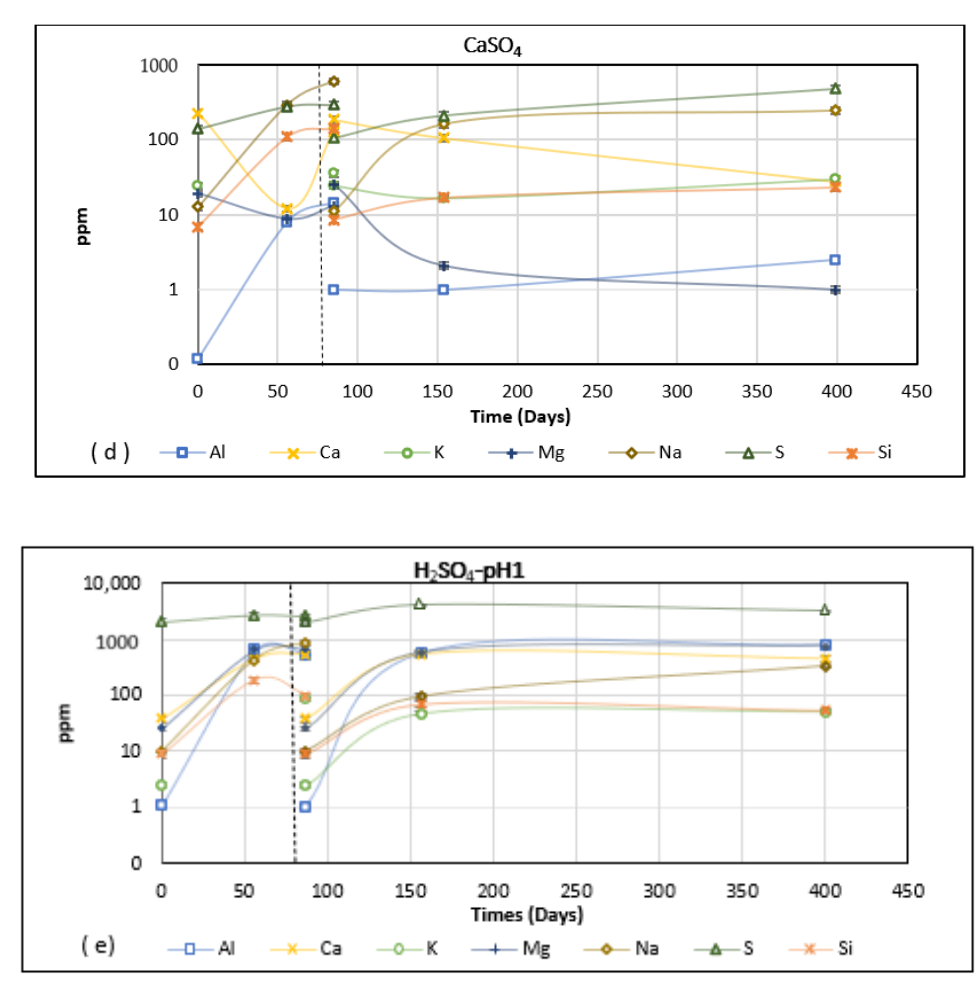
Figure 2. The results of inductively coupled plasma analysis of the exposure solutions before [i.e., ( a ) water; ( b ) Na 2 SO 4 ; ( c ) MgSO 4 ; ( d ) CaSO 4 ; ( e ) H 2 SO 4 -pH1] and after exposure to AASC and AAS/F concretes. Results represent an average of both Group 1 and Group 2 specimens.